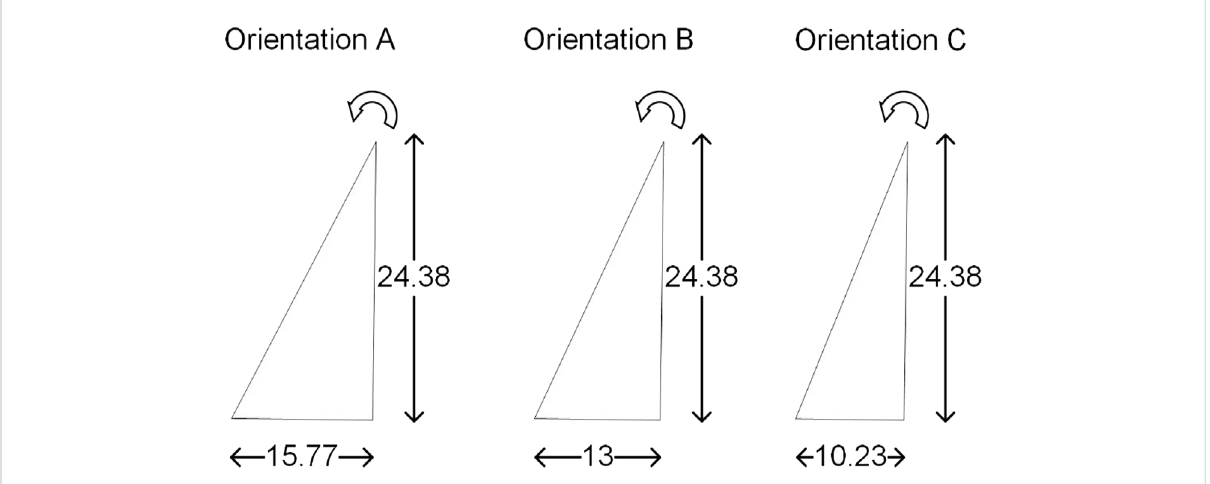
FIGURE 6 Converted equivalent triangles for calculating the tipping angles of three orientations of stove A, orientation A, B, and C: 32.9 ° , 28.1 ° , and 22.8 ° (unit: